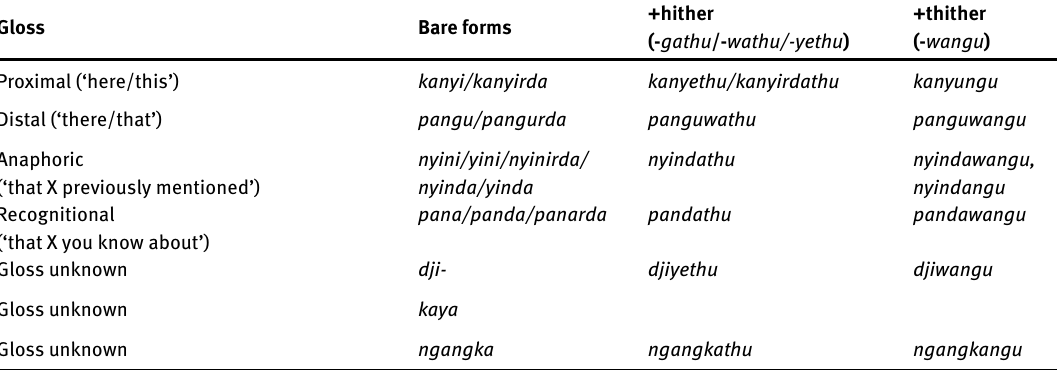
Table 1: The seven Murrinhpatha demonstratives.